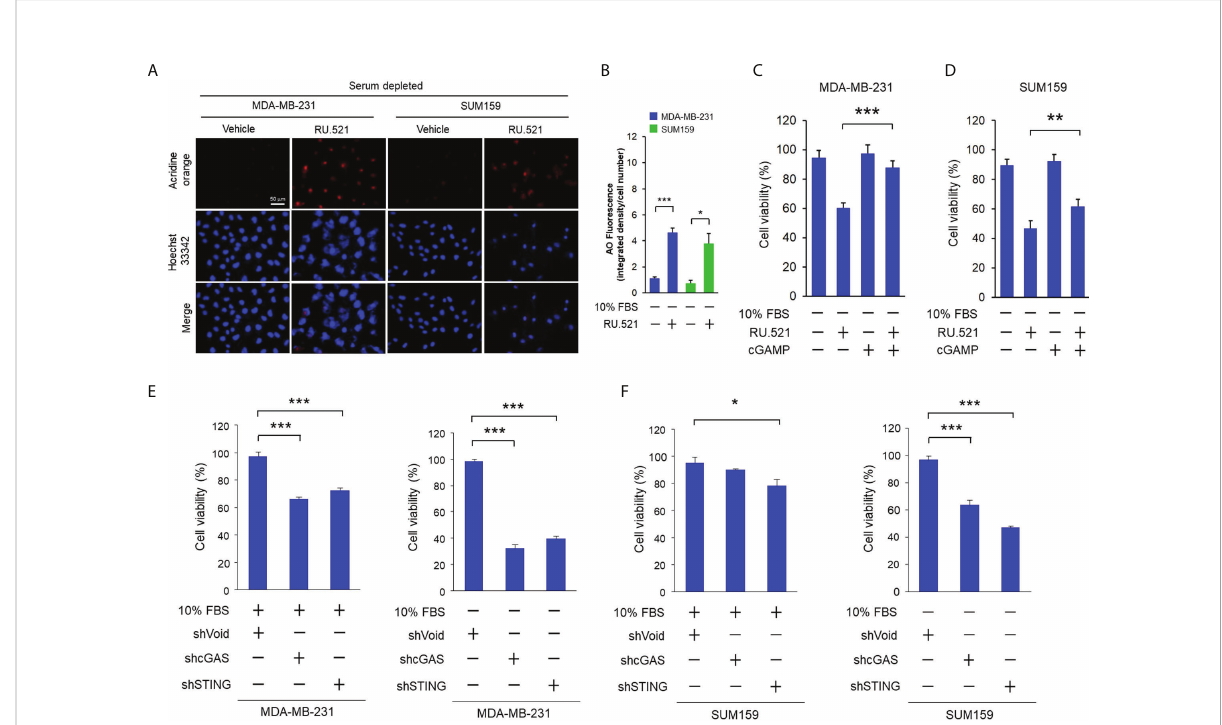
FIGURE 5 Stimulation of the cGAS-STING pathway rescued growth suppression by RU.521 under serum-depleted condition. (A) , MDA-MB-231 and SUM159 cells were treated with RU.521 at 10 m M and 8 m M, respectively, in serum-depleted media for 24 hr. Cells were then stained with acridine orange and red fl uorescence was captured by fl uorescence microscopy at 400x magni fi cation. The nuclei were counterstained by Hoechst 33342 (blue). Bar, 50 m m. (B) , The images of relative fl uorescence intensity were quantitated and plotted. The data from three independent biological repeats were plotted and presented as means ± SD. *, p < 0.05; ***, p < 0.001. Statistical signi fi cance was calculated by Student ’ s t-test. (C, D) MDA-MB-231 (C) and SUM159 (D) were transiently transfected with cGAMP (10 m M) by lipofectamine 2000, followed by treatment with RU.521 (8 m M) in serum-free media for 24 hr. Cell viability was measured by crystal violet staining and detected by absorbance at 595 nm. (E, F) MDA-MB-231 (E) and SUM159 (F) cells were infected by lenti-viral vectors expressing the shRNA against cGAS (shGAS), STING (shSTING), or the control vector, followed by culturing in serum-replete (+10% FBS) or serum-depleted (-10% FBS) media as indicated. Cell viability was measured by crystal violet staining and detected by absorbance at 595 nm. In each experiment, the data of three independent biological repeats are shown as means ± SD. *, p < 0.05; **, p < 0.01; ***, p < 0.001. Statistical signi fi cance was calculated by Student ’ s